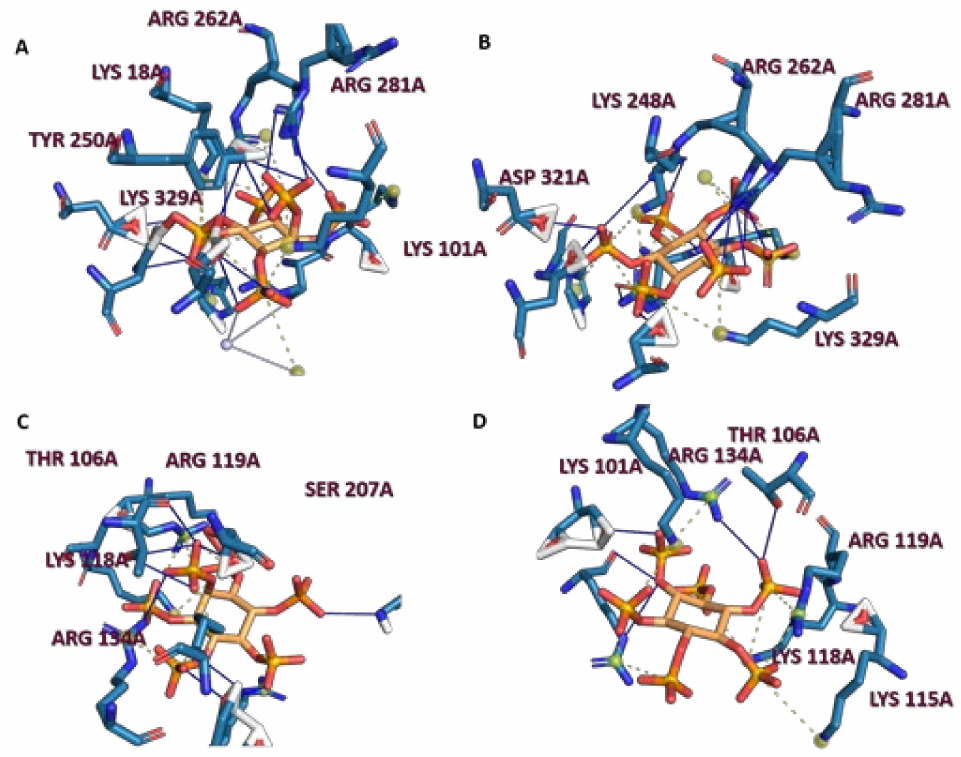
Figure 4. Molecular Docking results of myo and scyllo -IP 6 on PPIP5K2 and Eh IP6KA (GOLDScore); ( A ) myo -IP 6 at the active site of PPIP5K2; ( B ) scyllo -IP 6 at the active site of PPIP5K2; ( C ) myo -IP 6 at the active site of Eh IP6KA; ( D ) scyllo -IP 6 at the active site of Eh IP6KA. All interactions were visualized using PLIP while further image processing was carried out using PyMOL